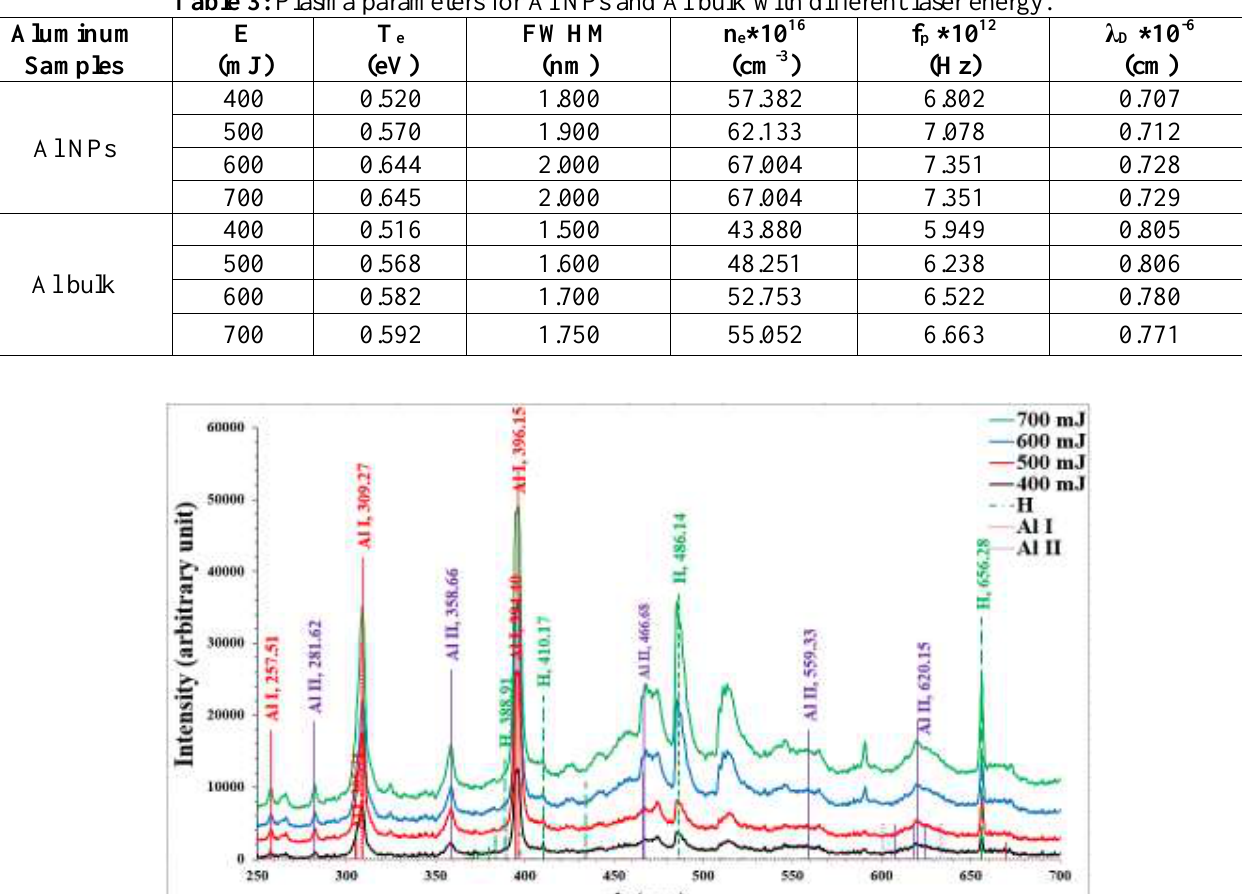
Table 3 lists the calculated electron temperature (T e ), electron density (n e ), plasma frequency (f p ) and Debye length (λ D ) for Al NPs as well as Al bulk target at different laser pulse energies (400 to 700 mJ) by using the Boltzman and Stark broadening. Because f p is proportional to n e , it indicates that f p raises as the laser energy increases, but λ D decreases. Table 3: Plasma parameters for Al NPs and Al bulk with different laser energy.